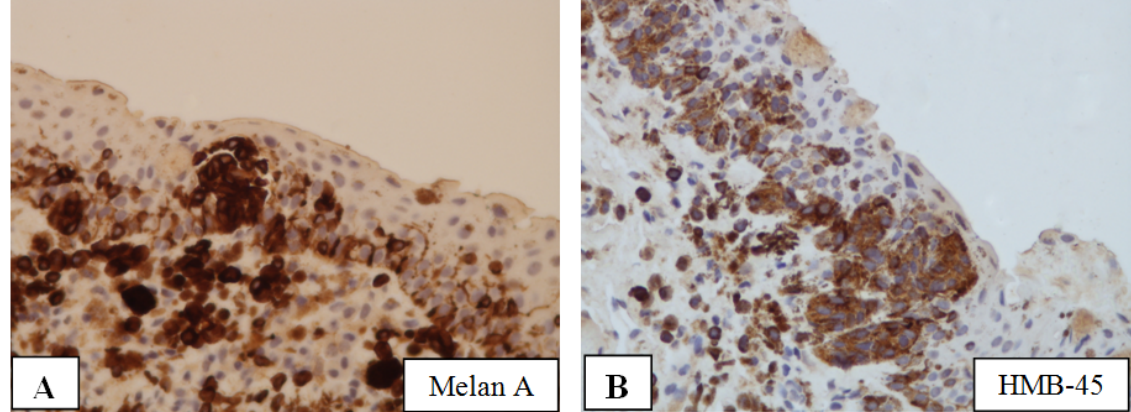
Figure 5: Immunohistochemical staining revealing that neoplastic cells were positive for melan A (A) and HMB-45 (B), indicating cells of melanocytic